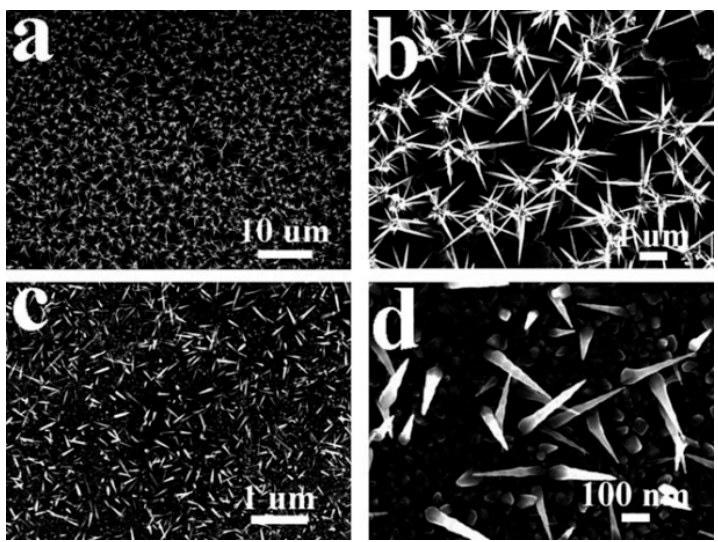
Figure 3. SEM micrographs of pure Pd thorn clusters ( a , b ) and the mixture of Pd thorns and Pd particles ( c , d ). Reproduced with permission from reference